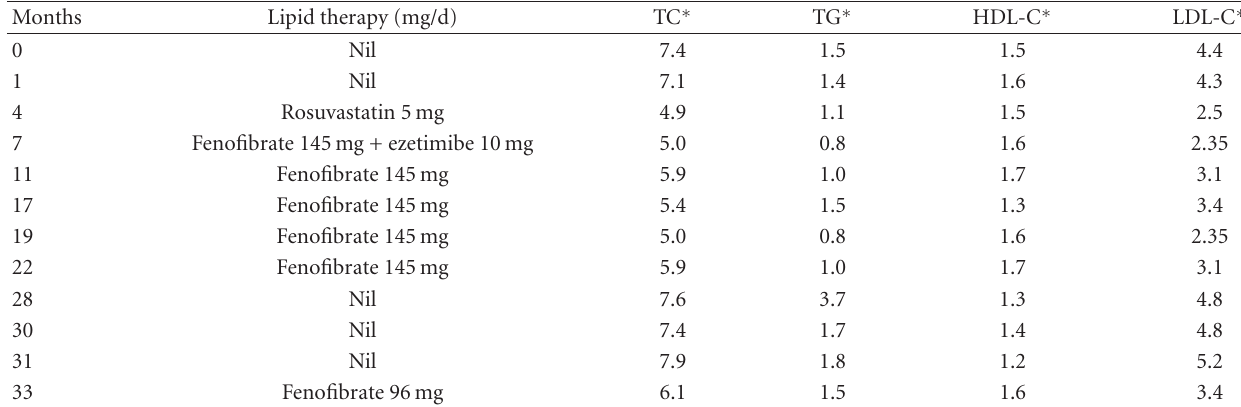
Table 1: Change in lipid levels with therapy.